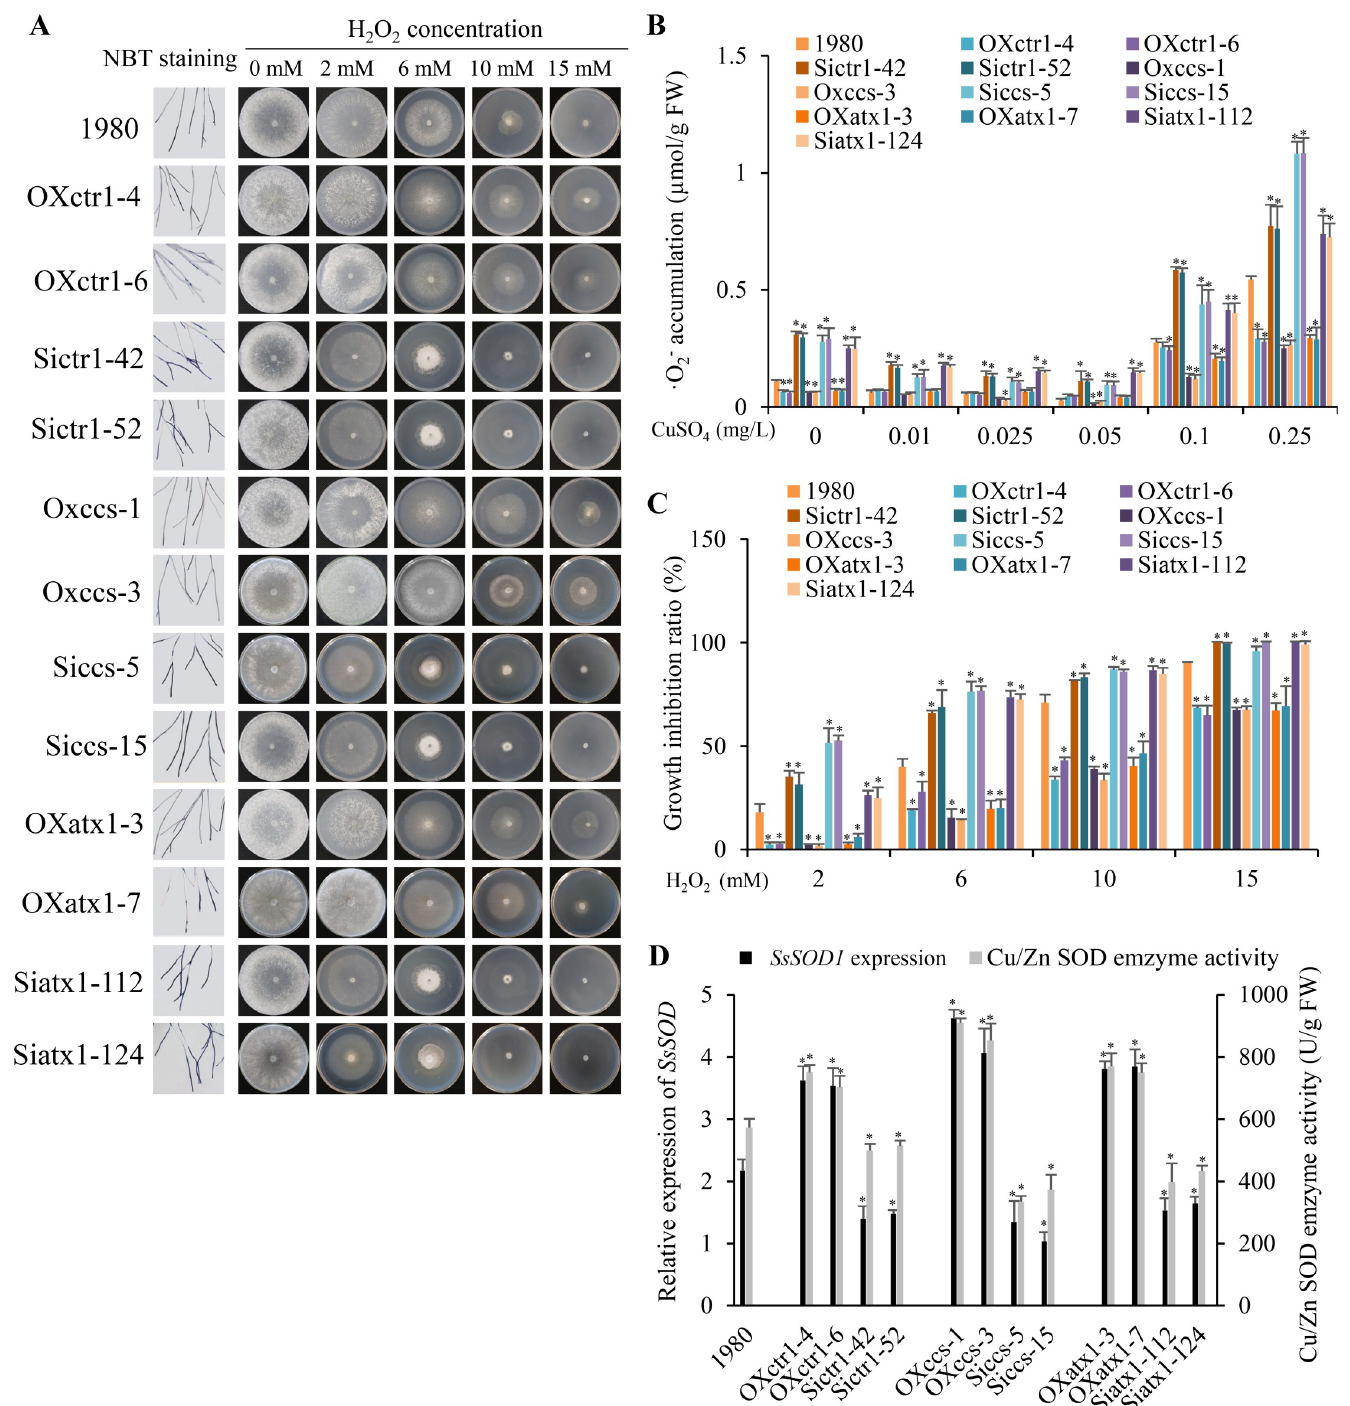
Fig 6. SsCTR1 , SsCCS and SsATX1 promotes antioxidant activity in S . sclerotiorum . (A) Accumulation of � O 2- (NBT staining at 24 hpi) in the hyphae tips and growth phenotypes on PDA supplemented with different concentrations of H 2 O 2 at 4 dpi. Five biological replicates in every independent experiments were analyzed. One representative replicate from the five experiments is shown. (B) Quantitative of � O 2- accumulation when supplemented with low- and high-concentration of CuSO 4 solutions. (C) The inhibition rate of hyphal growth on PDA supplemented with different concentrations of H 2 O 2 . In (B) and (C), error bars indicate standard deviation of five independent experiments with five plates for every sample in one replicate. (D) Relative expression of S . sclerotiorum SsSOD1 and enzyme activity of Cu/Zn SOD in wild-type strain 1980, silenced and overexpression strains. Relative expression of S . sclerotiorum SsSOD1 was indicated by qRT-PCR analysis. The